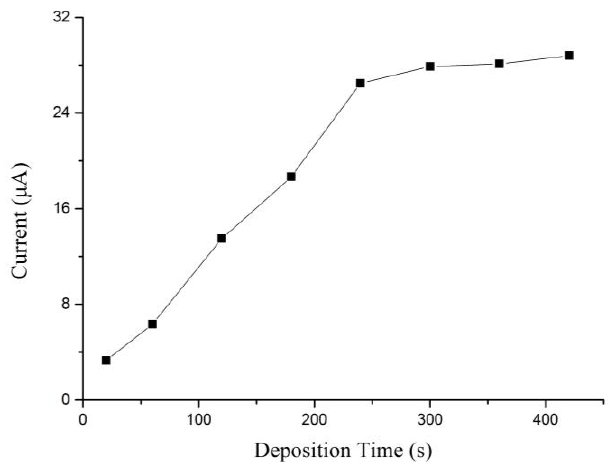
Figure 8. Effects of deposition time on the stripping peaks current of 35 µg/L Cd(II).